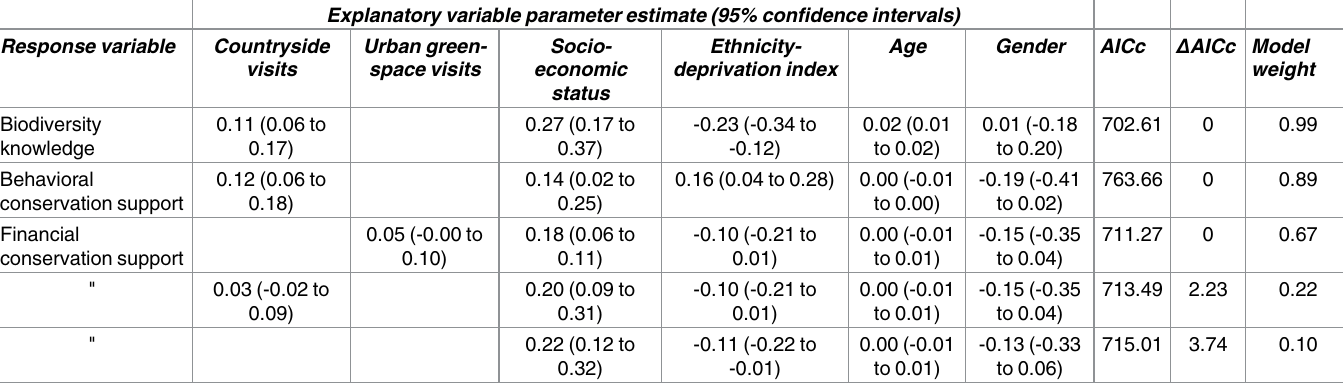
Table 1. Multiple regression models of biodiversity knowledge and conservation support as a function of visitation rates to urban green-space and the countryside.